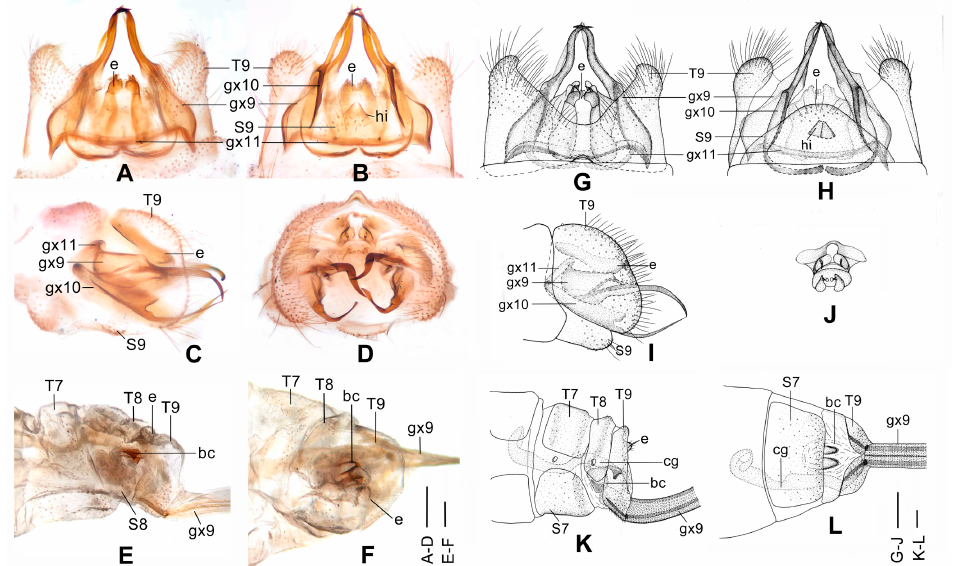
Figure 4. Dilar cangyuanensis sp. nov. ( A – D ) male holotype, genitalia, photographs: ( A ) dorsal view; ( B ) ventral view; ( C ) lateral view; ( D ) caudal view. ( E – F ) female, genitalia, photographs: ( E ) lateral view; ( F ) dorsal view. ( G – J ) male holotype, genitalia, line drawings: ( G ) dorsal view; ( H ) ventral view; ( I ) lateral view; ( J ) ectoproct, caudal view. ( K – L ) female, genitalia, line drawings: ( K ) lateral view; ( L ) ventral view. bc: bursa copulatrix; cg: colleterial gland; e: ectoproct; gx9: gonocoxite 9; gx10: gonocoxite 10; gx11: fused gonocoxites 11; hi: hypandrium internum; S7–9: sternum 7–9; T7–9: tergum 7–9. Scale bars: 0.2 mm.